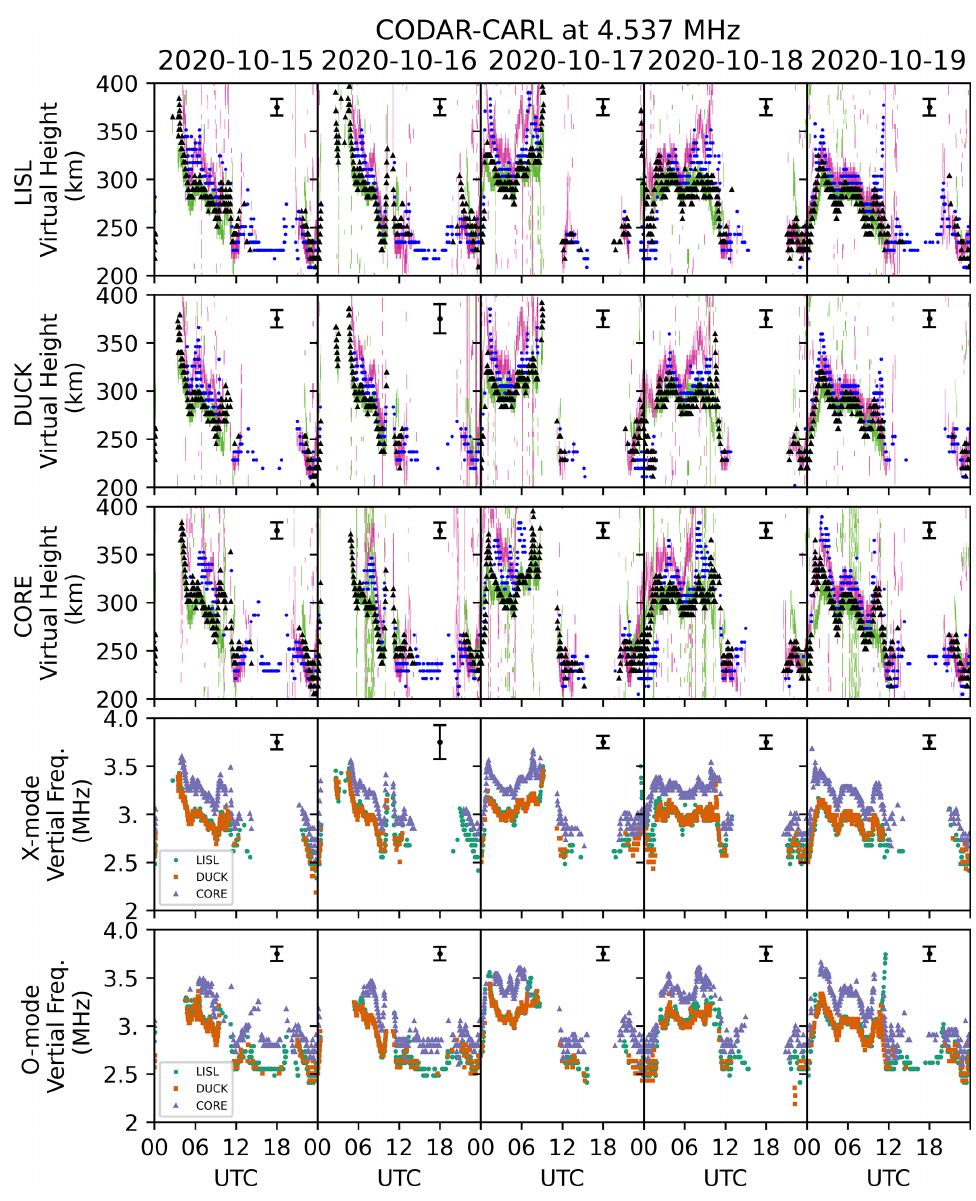
Figure 4. A virtual height–time derived using the oblique CODAR–CARL observations vs. the WP397 digisonde at Wallops Island, VA, between 15 and 19 October 2020. In the top three rows, the X- and O-mode virtual height time series are plotted as black triangles and blue dots, respectively. The WP937 X mode and O mode at the frequency nearest to the equivalent vertical frequency derived using the CODAR observations are shown as green and purple, respectively. From top to bottom, rows 1–3 show the virtual height calculated from the LISL, DUCK, and CORE CODARs. The error bar plotted at 18:00UTC is the maximum propagated uncertain estimated, calculated using Eq. (13). Rows 4 and 5 show the vertical frequency calculated using the secant law in Eq. (11) for the X and O mode, respectively. More details can be found in the